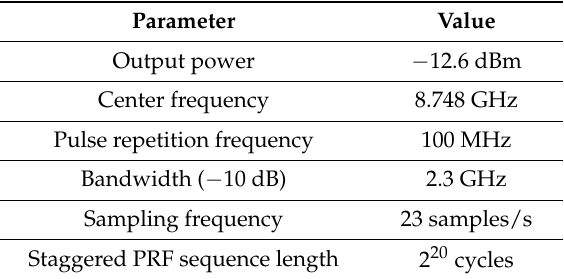
Table 1. Radar transceiver parameters.